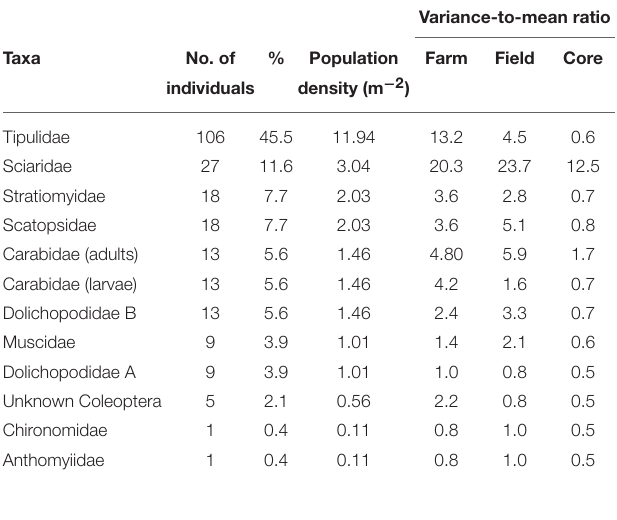
TABLE 1 | The number of individuals of each taxa, their percentage of the total 233 insects obtained from 1130 cores collected in 2012 over 19 fields in 3 farms, the population density based on an area of approximately 9 m 2 (the total area of soil cores taken from the study) and the variance-to-mean ratio for the taxa collected at the farm, field, and core scale in 2012.